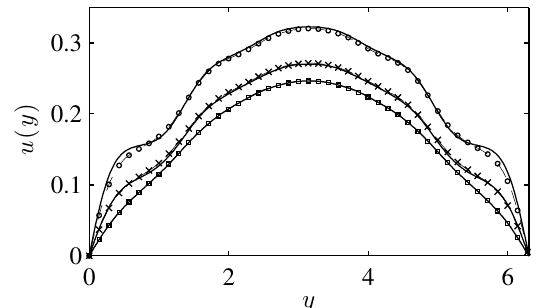
Figure 8. Comparison between velocity profiles obtained directly from MD simulations and predictions of the truncated functional expansion using independently calculated response functions for a single sinusoidal component STF and a three component SLF. Bold lines represent MD simulations, while thin dashed lines with symbols represent predictions. The system parameters labels are the same as those used in Figure 7. Velocity profiles are only shown for half of a wave cycle. Reprinted figure